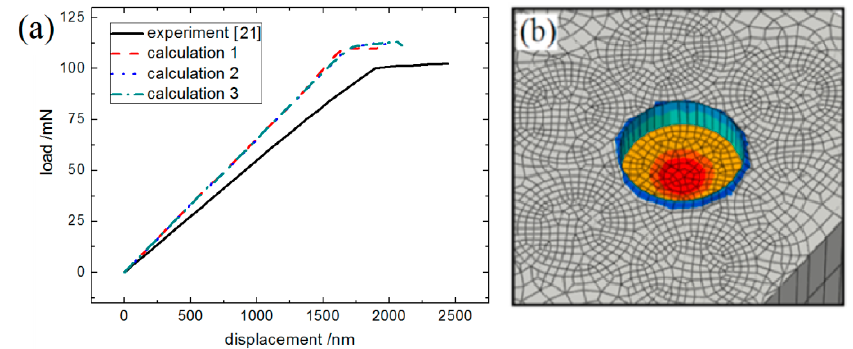
Figure 17. A comparison between the simulation and experimental results of the C/C composite fiber ejection test: ( a ) the load–displacement curves; ( b ) the deformation of the ejected fiber in the simulation.